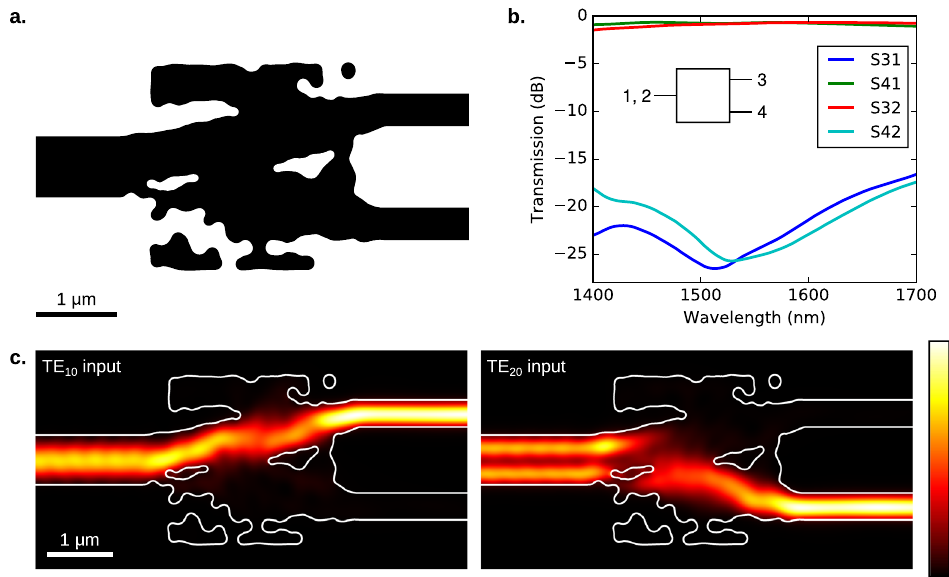
Figure 2. A spatial mode demultiplexer that takes the TE 10 and TE 20 modes of a 750 nm wide input waveguide, and routes them to the TE 10 mode of two 400 nm wide output waveguides. Here, we present ( a ) the final design, ( b ) simulated S-parameters, and ( c ) the electromagnetic energy density and μ are the permittivity and permeability, and E and H are the electric and magnetic fields respectively. The fields and S-parameters were calculated using finite-difference time-domain (FDTD) simulations. The boundaries of the device are outlined in white.